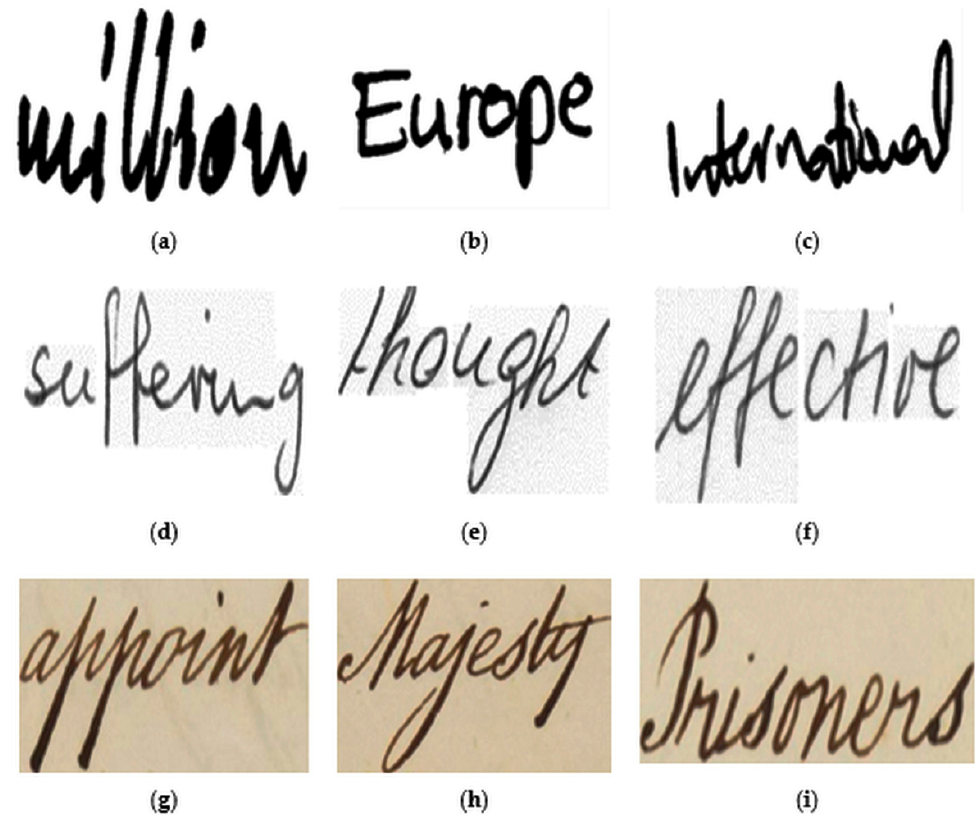
Figure 8. Samples of query images taken from ( a – c ) QUWI database, ( d – f ) IAM database, and ( g – i ) ICDAR2015 KWS database.